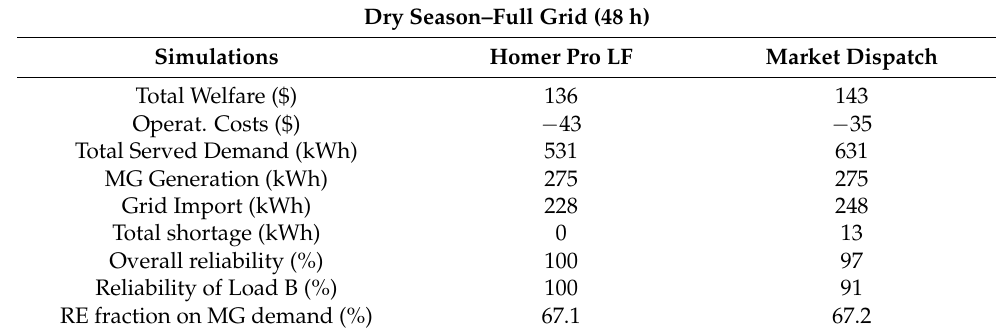
Table 3. Comparison table for simulation results under dry season with a reliable main grid. Dry Season–Full Grid (48 h)